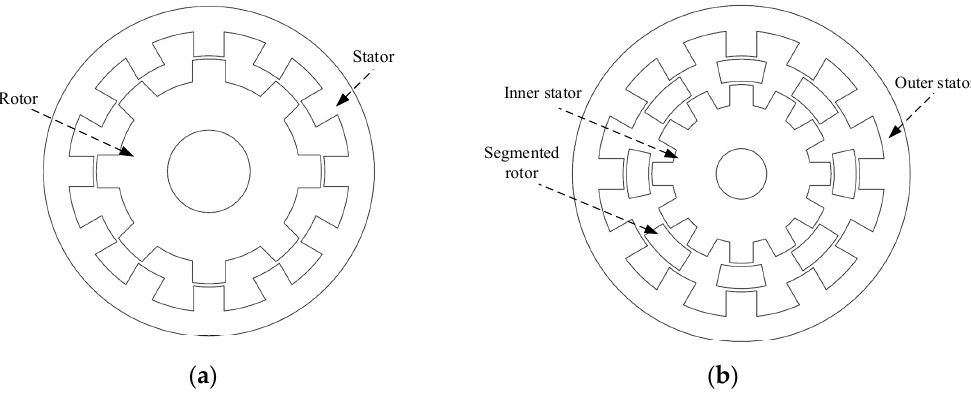
Figure 1. Profiles of: ( a ) switched reluctance motor; and ( b ) double-stators switched reluctance motor.